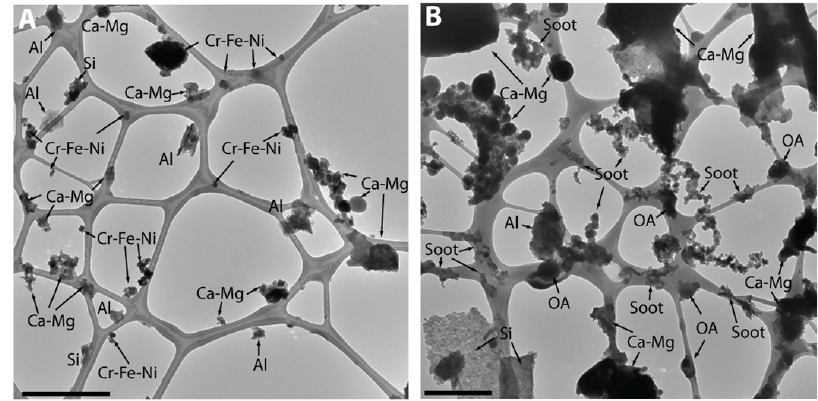
Fig. 7. TEM image of smoke samples from (a) garbage burning and (b) mixture of garbage burning and crop residue burning. The black horizontal bar at the base of each image indicates 1 micron. See Sect. 3.2 for discussion.